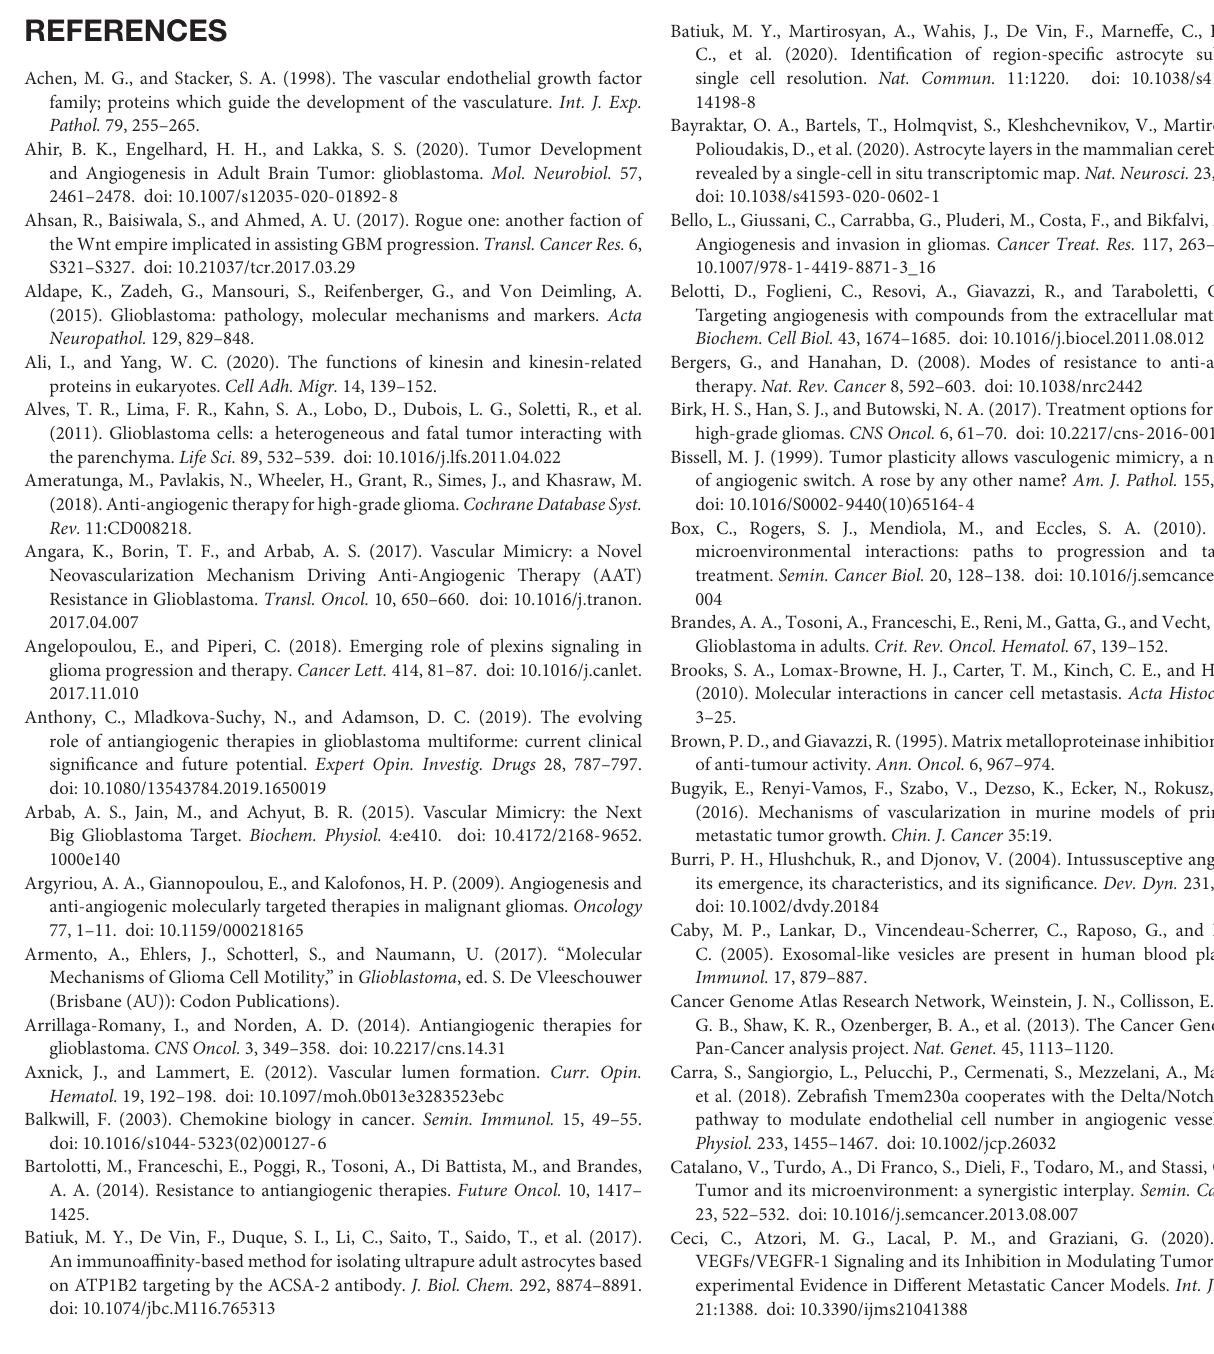
Supplementary Table 5 | All enriched pathways identified different between high or low TMEM230 expression in glioblastoma of patients from DEG. Supplementary Table 6 | All enriched pathways identified different between glioblastoma and LGG from DEG. Supplementary Table 7 | All enriched pathways identified different between high or low TMEM230 expression in LGG from DEG. Supplementary Table 8 | All enriched pathways identified different between high or low TMEM230 expression in GBM and astrocytes from DEG.